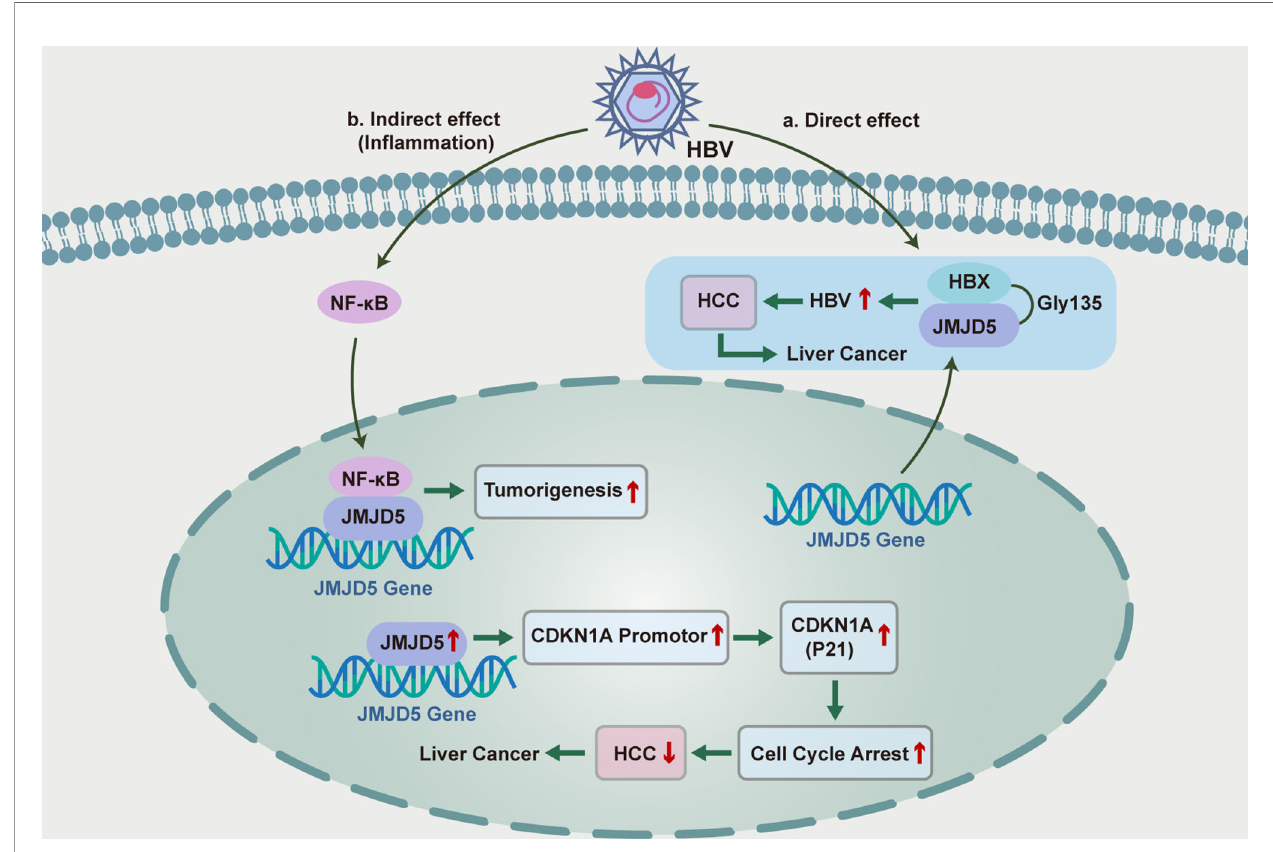
FIGURE 2 | Functional roles and mechanisms of JMJD5 in the in fl ammatory regulation of HBC-induced hepatocellular